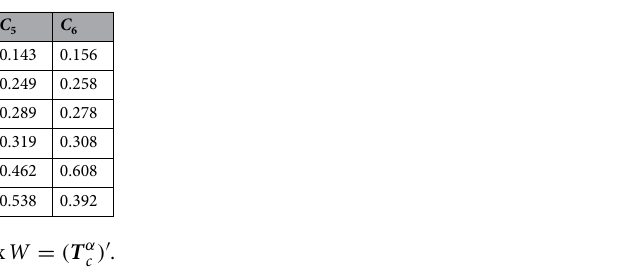
Table 5. The unweighted supermatrix W = ( T α c ) ′ .